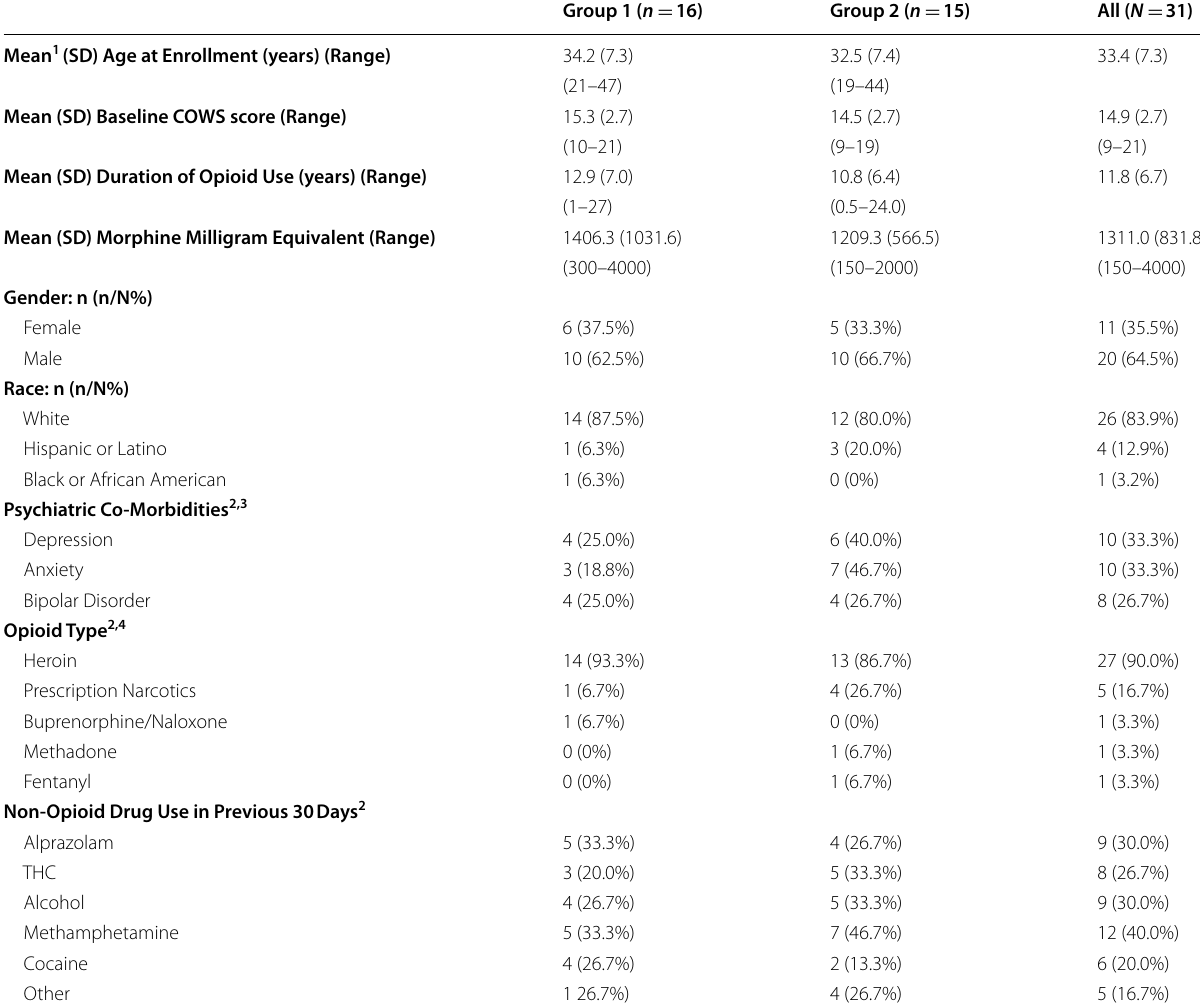
Table 1 Baseline characteristics of the intention-to-treat